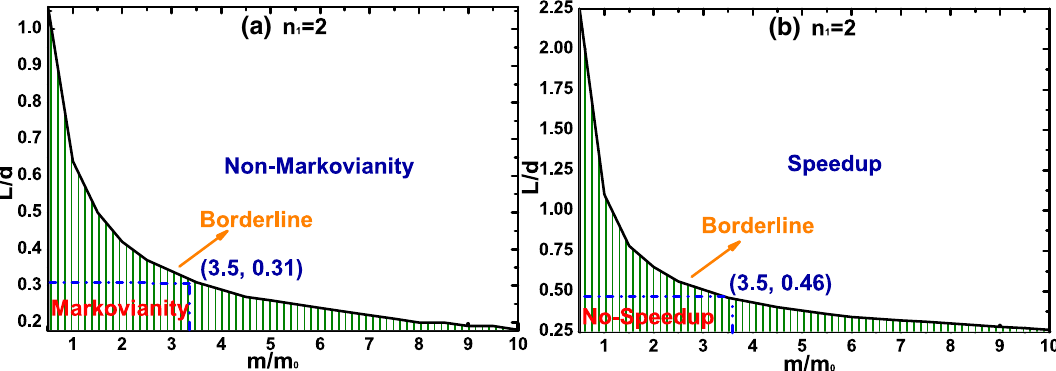
τ − m plane for the crossover between no-speedup dynam- QSL in the L ics and speedup dynamics. Here the actual evolution time τ = 0 . 4 s, d = 250 µ m and m 0 = 10 − 13